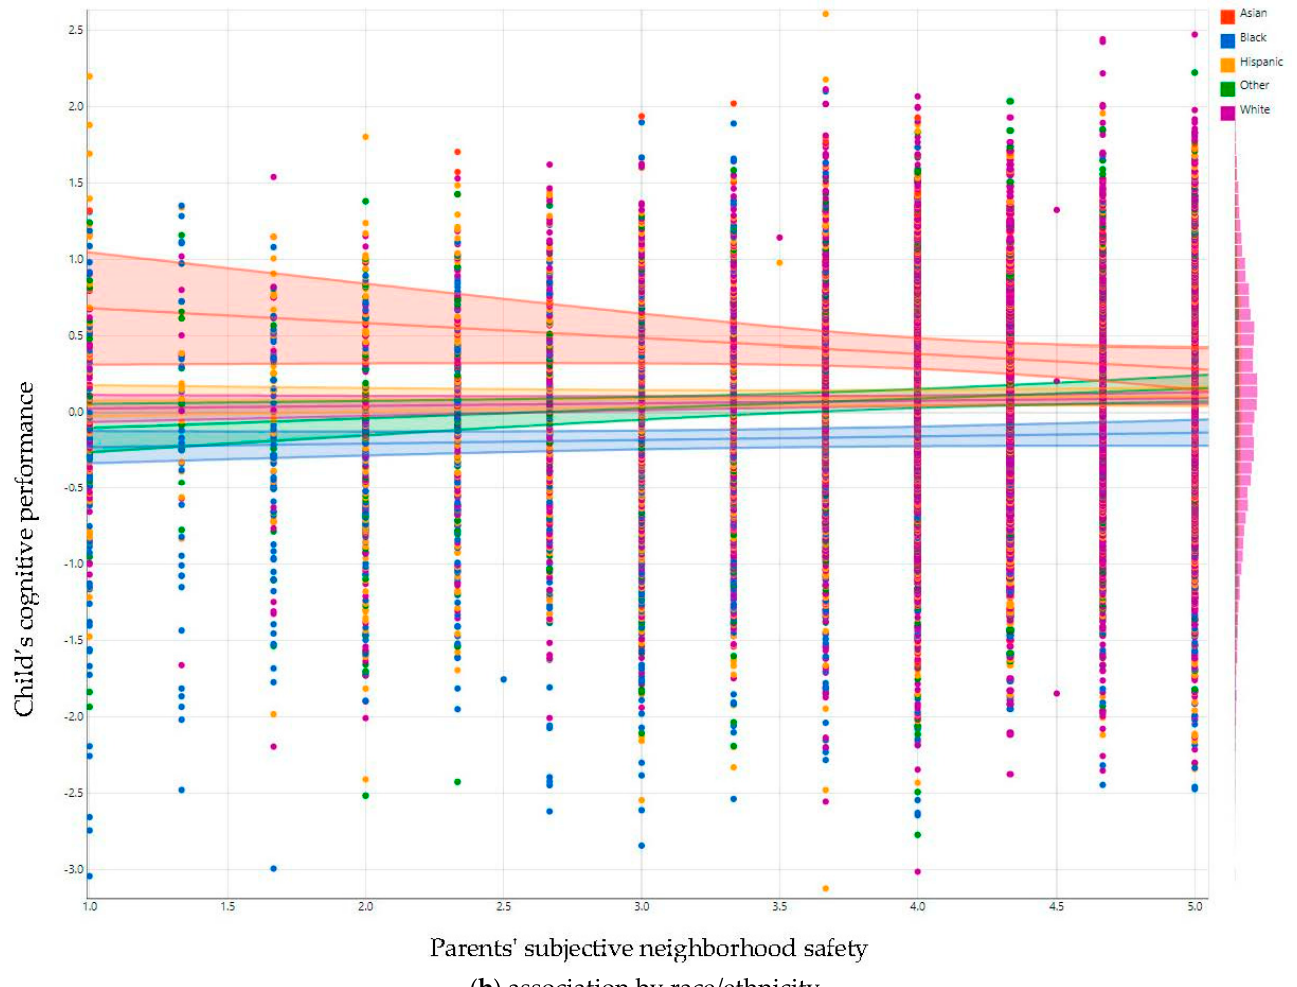
Figure 2. Association between parents’ subjective neighborhood safety and children’s executive functioning overall and by race/ethnicity.